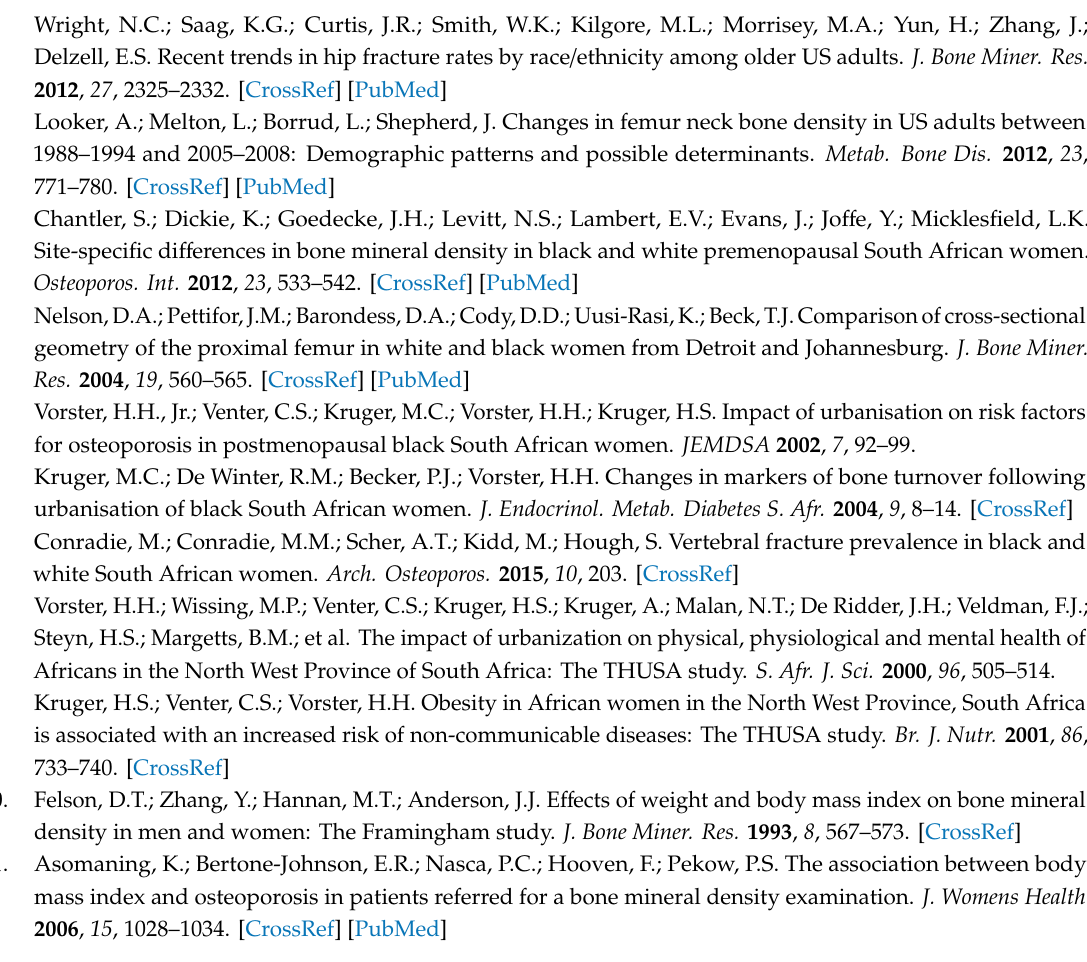
Table S1: Baseline characteristics of participants per tertile of adherence to the “staple food and processed meats”, “home-cooking and whole foods”, “snacking”, or “high sugar” dietary